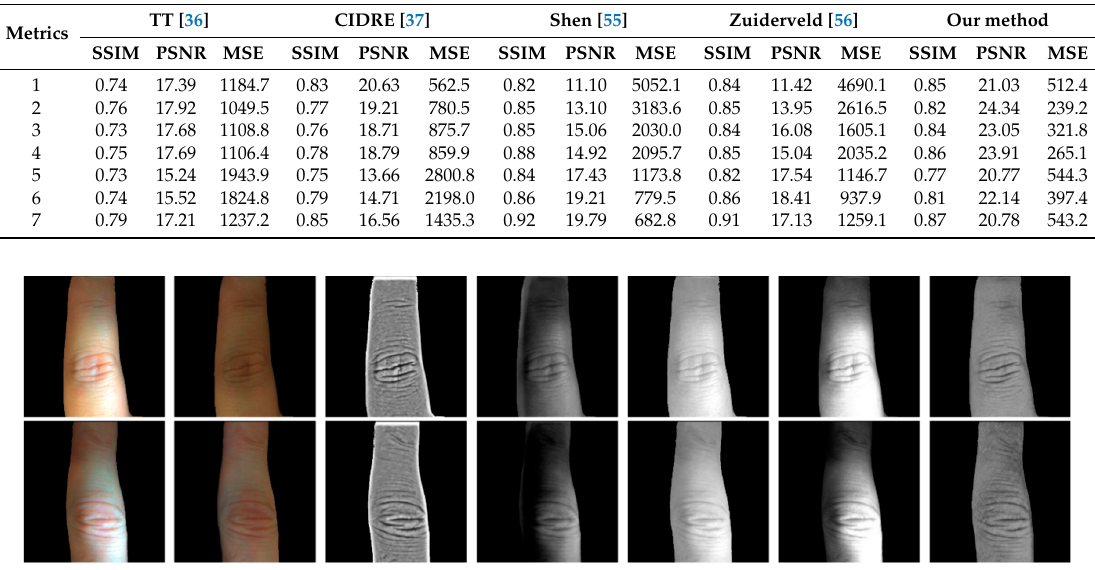
Table 1. Quantitative comparison results.